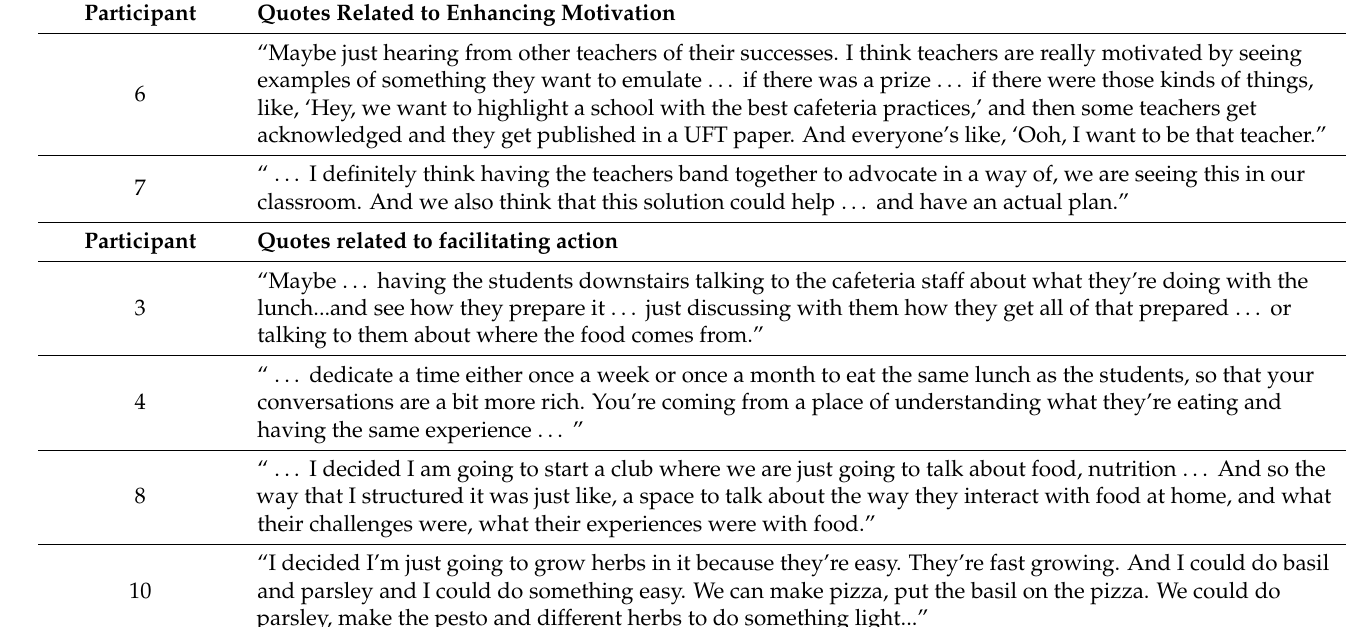
Table 2. Illustrative quotes from participants related to the components of professional development (i.e., enhancing motivation, facilitating action, and environmental supports).